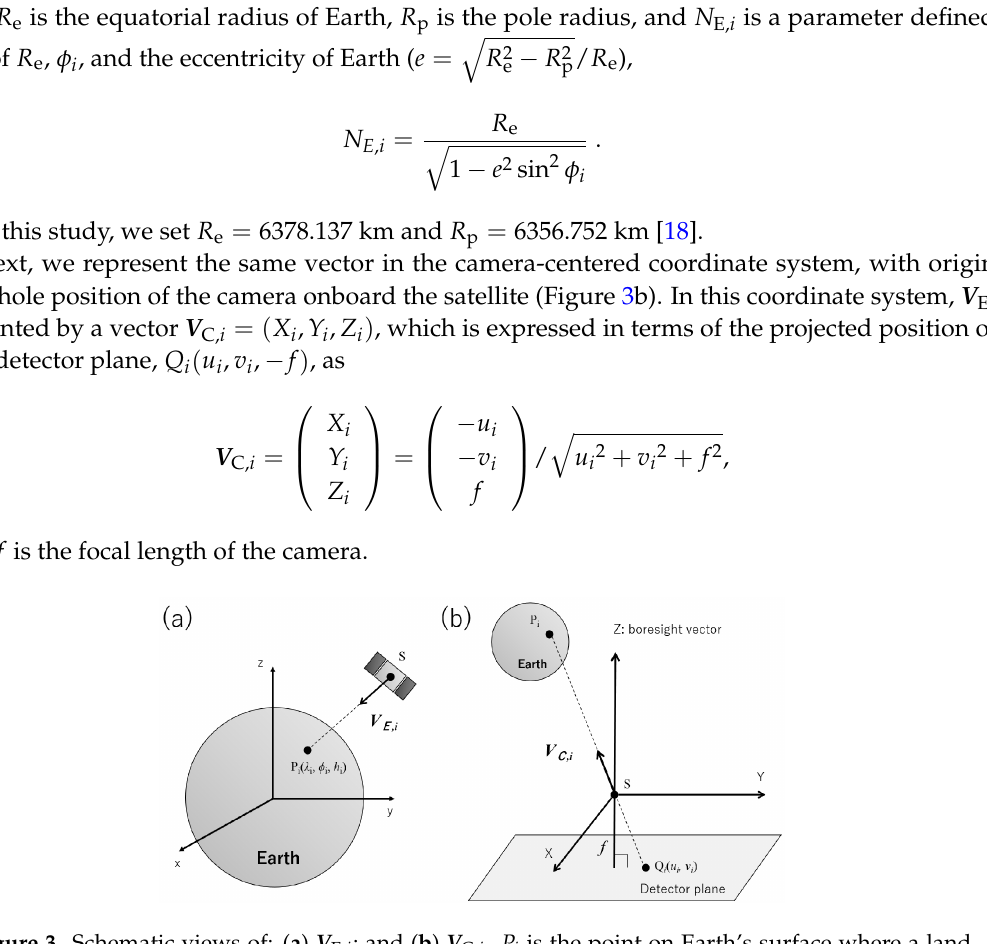
Figure 3. Schematic views of: ( a ) V E, i ; and ( b ) V C, i . P i is the point on Earth’s surface where a land feature has been detected, and Q i is its projected point on the detector